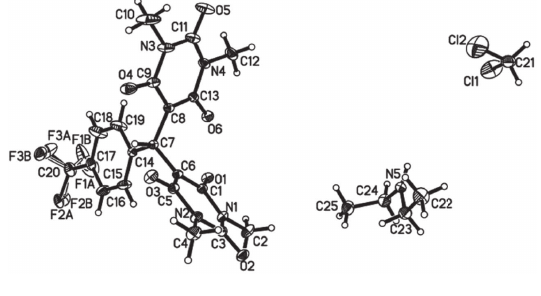
Table 1: Data collection and handling.